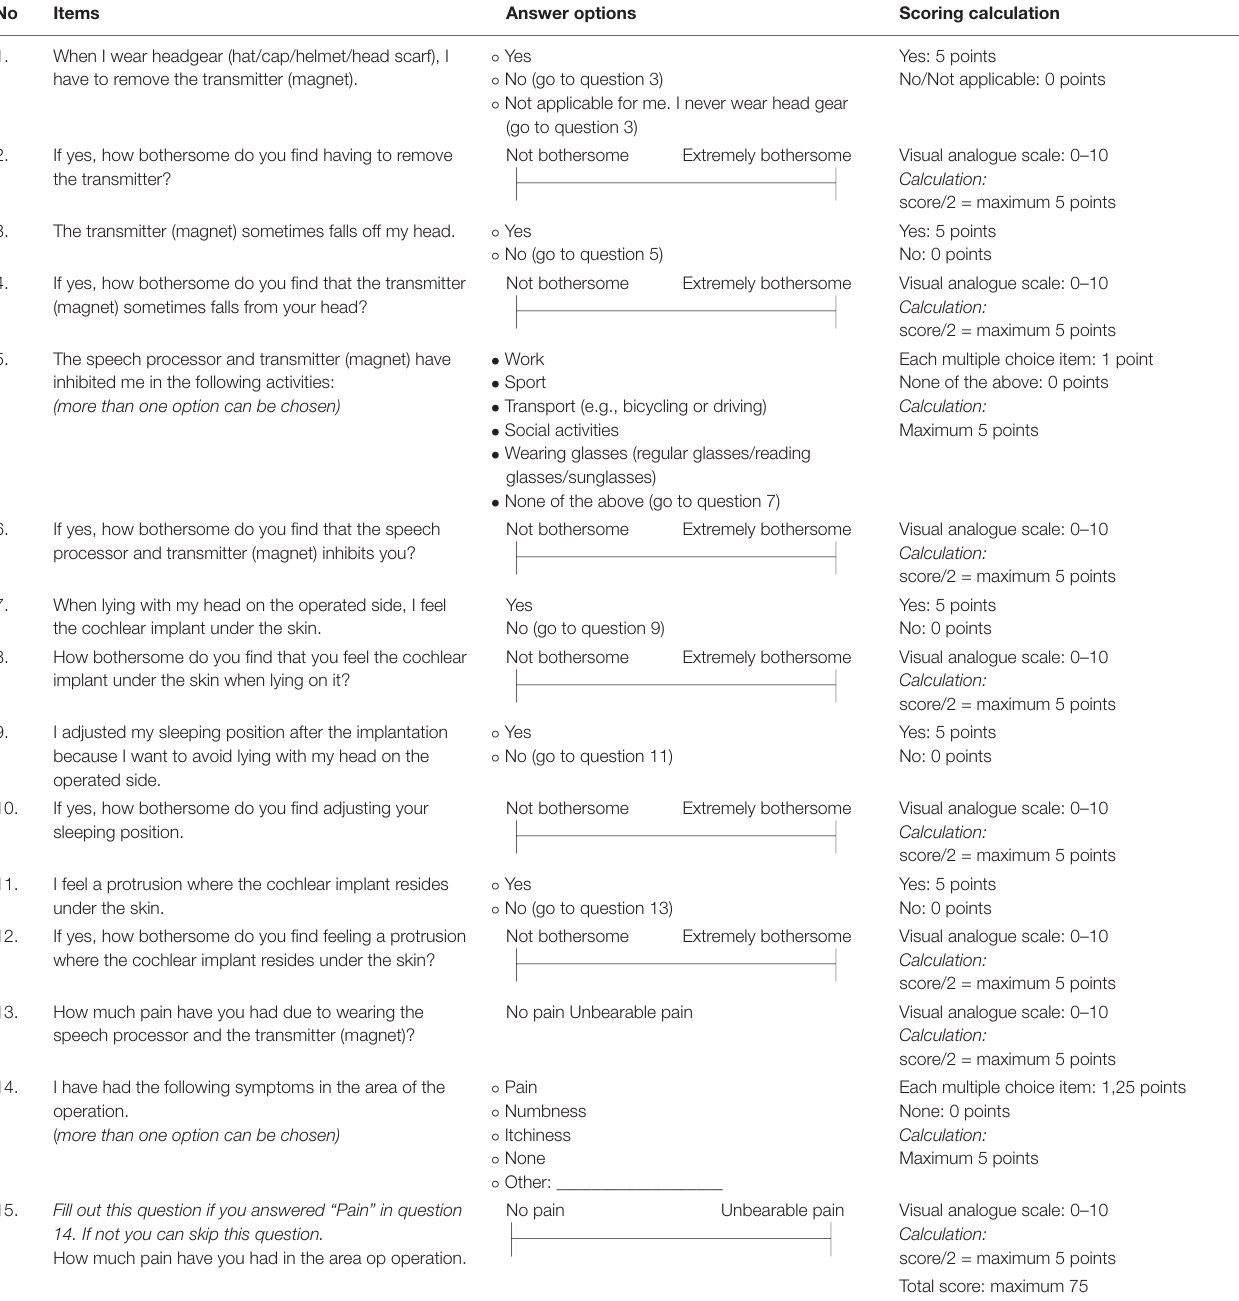
TABLE 2 | COMPASS questionnaire items, answer options, and scoring calculations (not original lay-out). Answer options Scoring